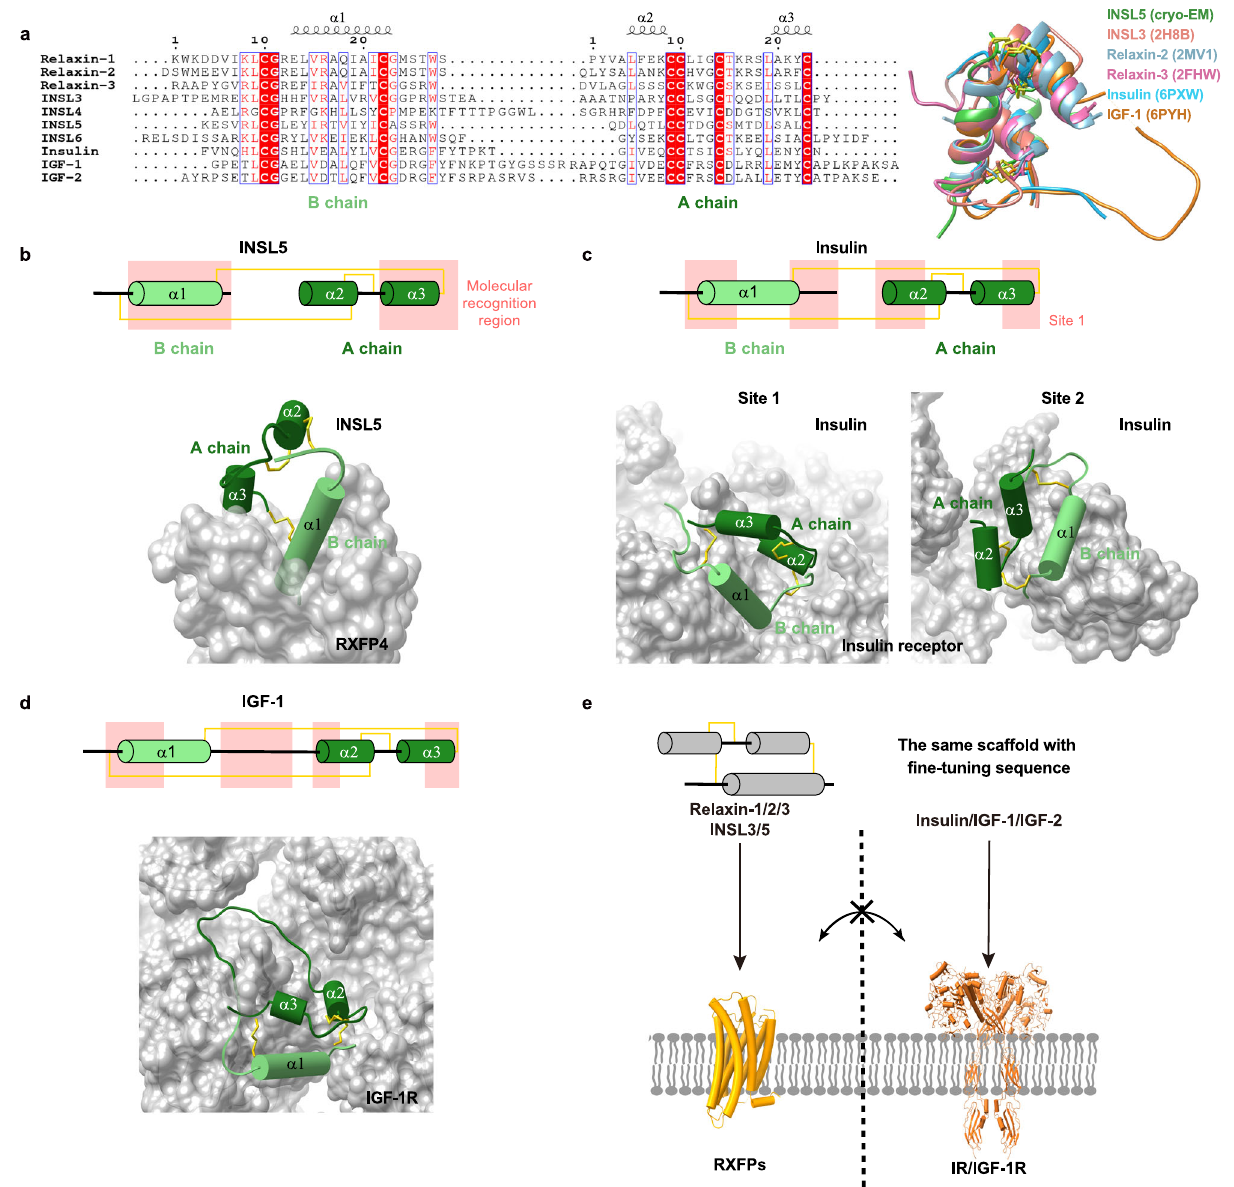
Fig. 6 | Ligand recognition in the insulin superfamily. a Sequence alignment (left) and structure superimposition (right) of peptides in the insulin superfamily colored as the labels. b – d Recognition of INSL5 ( b ) insulin (PDB code: 6PXW) ( c ) and IGF-1 (PDB code: 6PYH) ( d ) by cognate receptors, where the peptide (green)